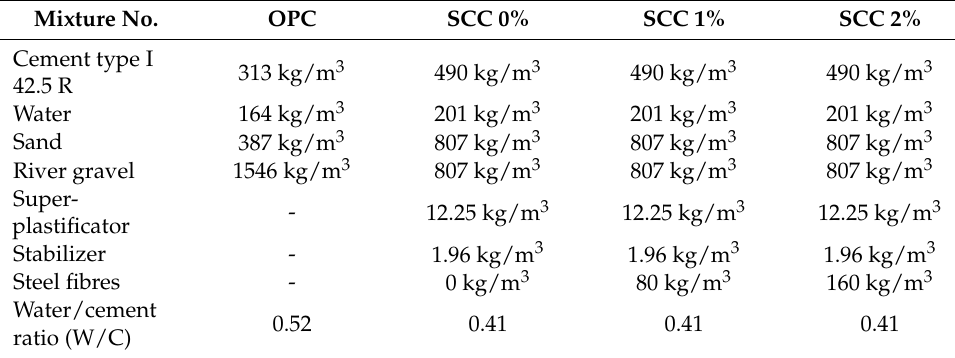
Table 1. Components of concrete mixtures